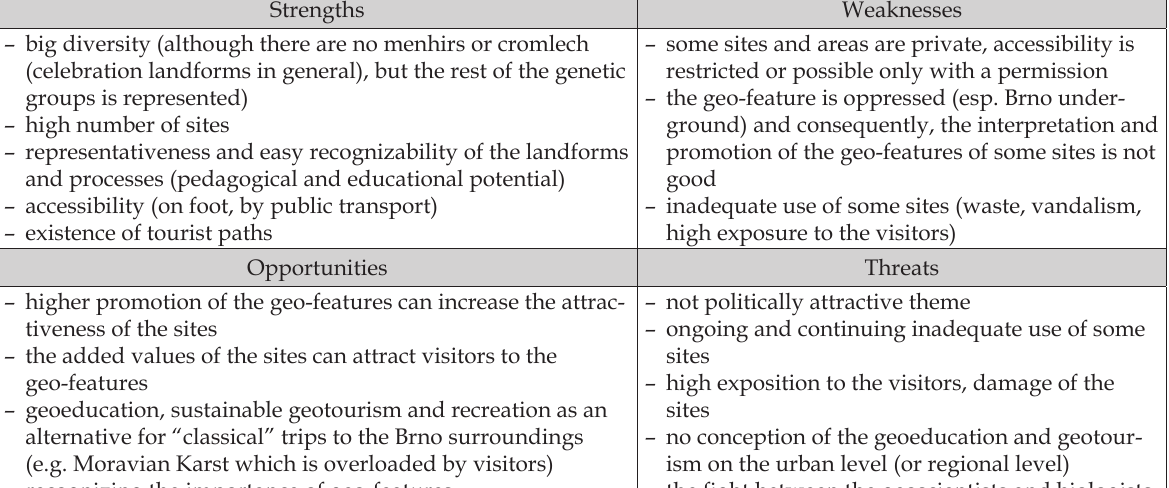
Table 1. SWOT analysis of the geotourist and geoeducational potential of the anthropogenic landforms within Brno